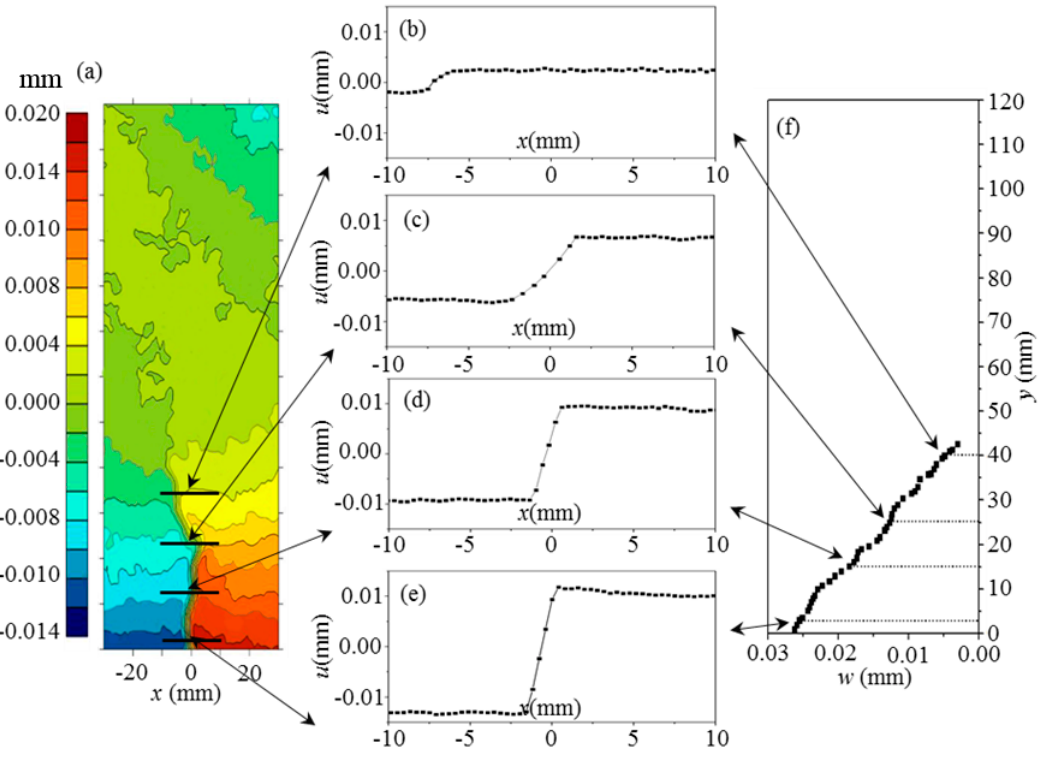
Figure 6. Standard TPB at the peak load. ( a ) Opening displacement contour. ( b ) Opening displacement pattern along y = 40 mm. ( c ) Opening displacement pattern along y = 25 mm. ( d ) Opening displacement pattern along y = 15 mm. ( e ) Opening displacement pattern along y = 3 mm. ( f ) Crack opening displacement (COD) profile along the fracture process zone (FPZ).